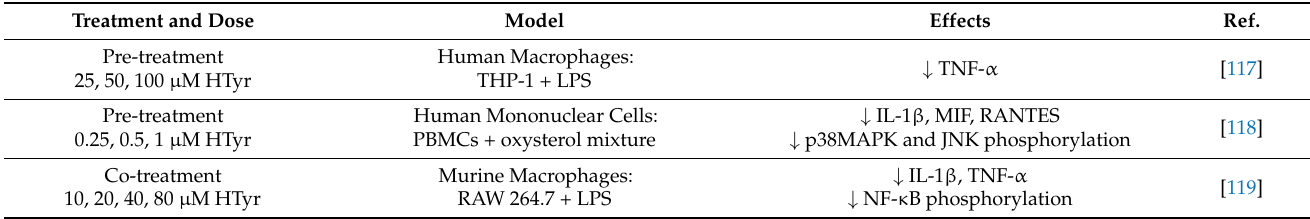
Table 1. In vitro effects of HTyr on inflammation. Treatment and Dose Model Effects